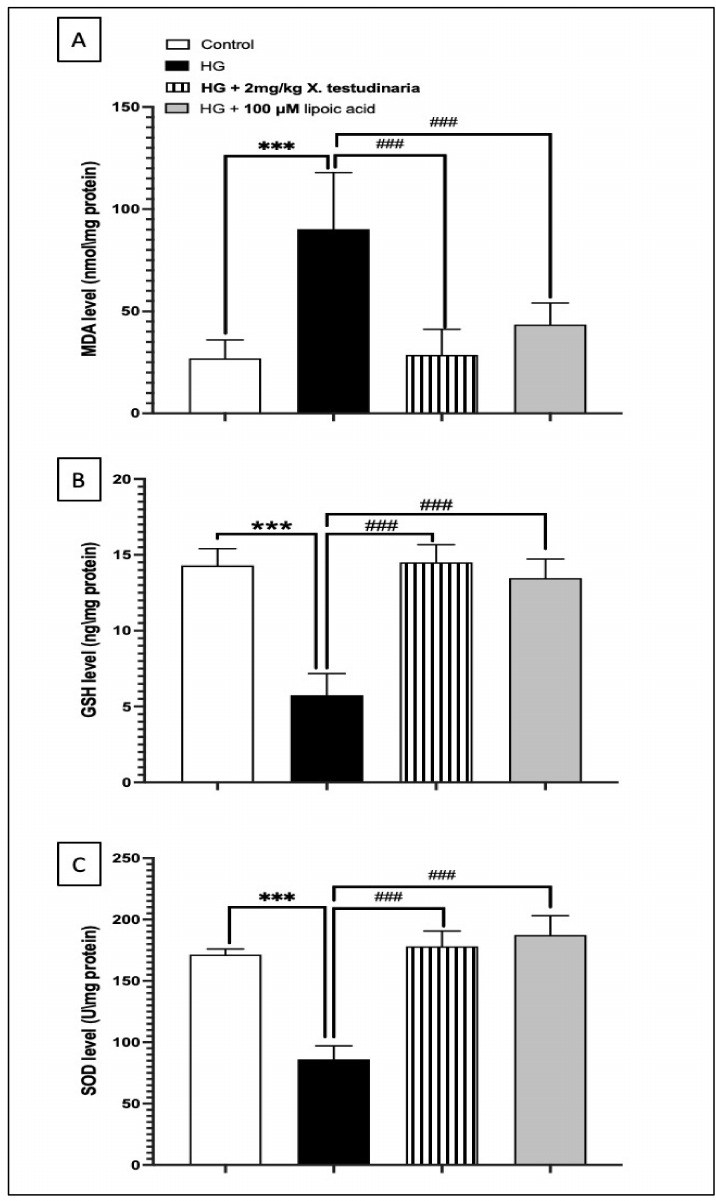
Figure 2. The effect of X. testudinaria extract on oxidative stress biomarkers in high glucose (HG) -DRG culture: ( A ) malondialdehyde (MDA) level, ( B ) glutathione (GSH), and ( C ) superoxide dismutase enzymes (SOD). Data are presented as mean ± SEM for the three independent experiments. Statistical analysis was carried out using a one-way ANOVA followed by Tukey post hoc test. ***: statistical significance from the corresponding control group was set at p < 0.001. ###: statistical significance from the corresponding HG group was set at p <